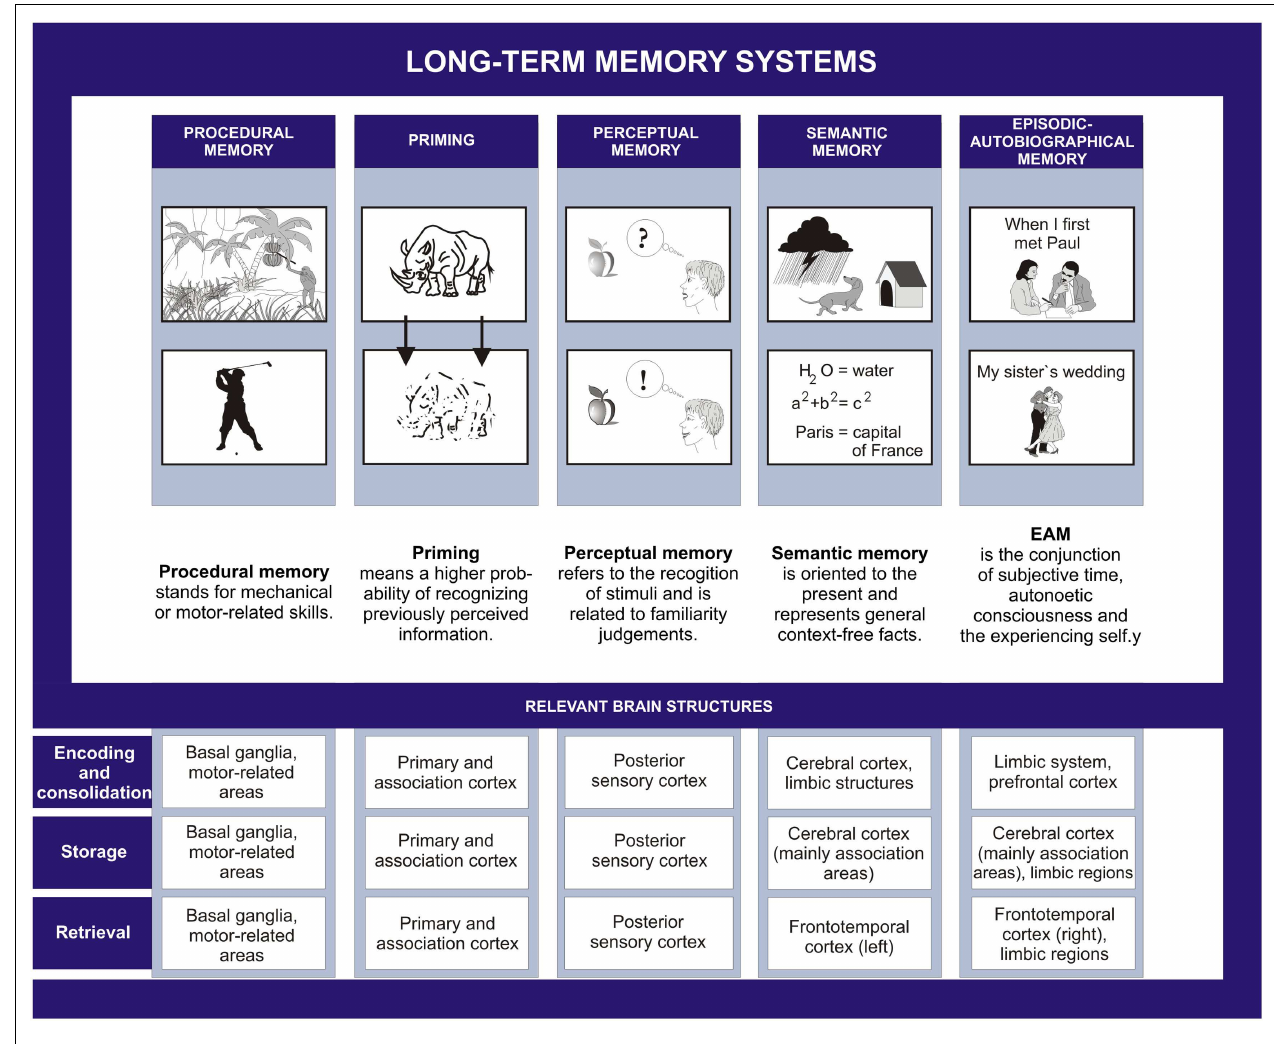
FIGURE 1 |The five long-term memory